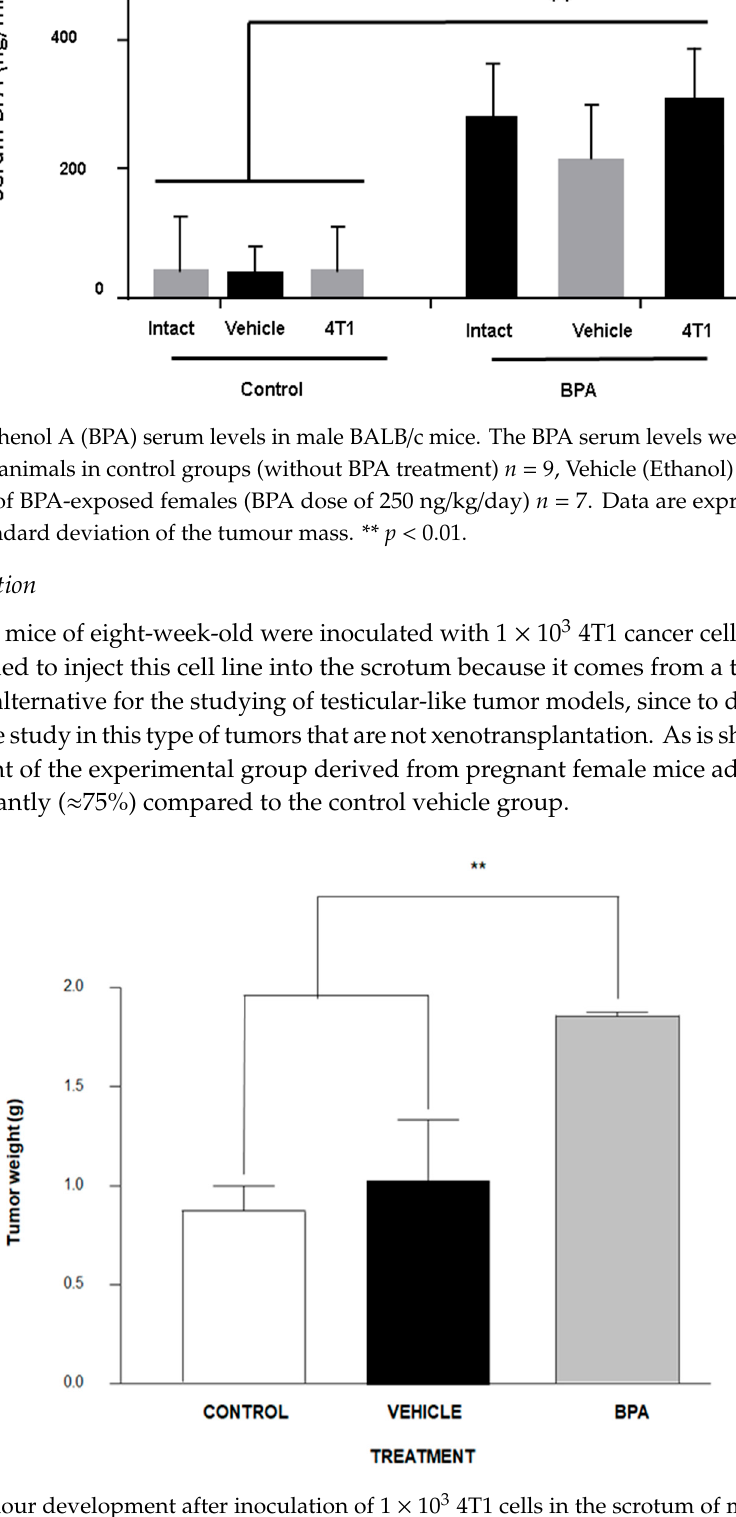
Figure 2. Tumour development after inoculation of 1 × 10 3 4T1 cells in the scrotum of male BALB/c mice. Control (no treatment) n = 9, Vehicle (Ethanol) n = 7 and offspring of BPA-exposed female (BPA 250 ng/kg/day) n = 7. Data are expressed as the mean and standard deviation of the tumour mass. ** p < 0.01.